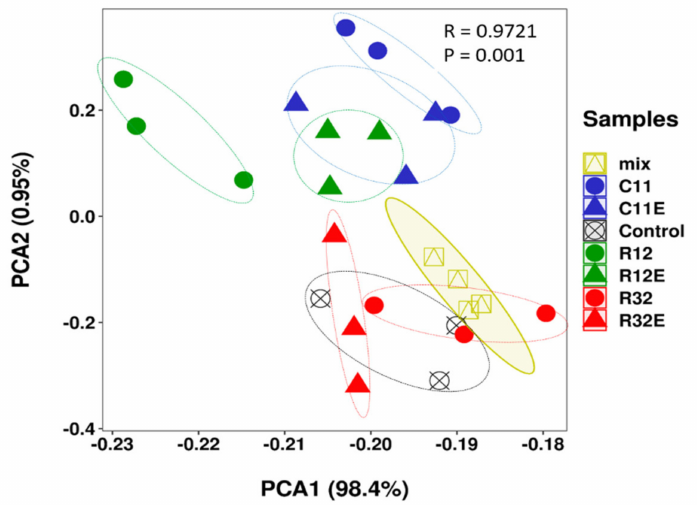
Figure 1. Principal component analysis (PCA) showing the overall metabolite patterns in grape cells of different treatments. The mixed sample group (mix) contains samples randomly uploaded during metabolite profiling for technical quality control. C11, R12, R32, C11E, R12E, and R32E briefly represent the sample groups treated with the corresponding endophytic fungal strains or their derived fungal extracts. Samples belonging to one treatment pair are exhibited as the same color in the